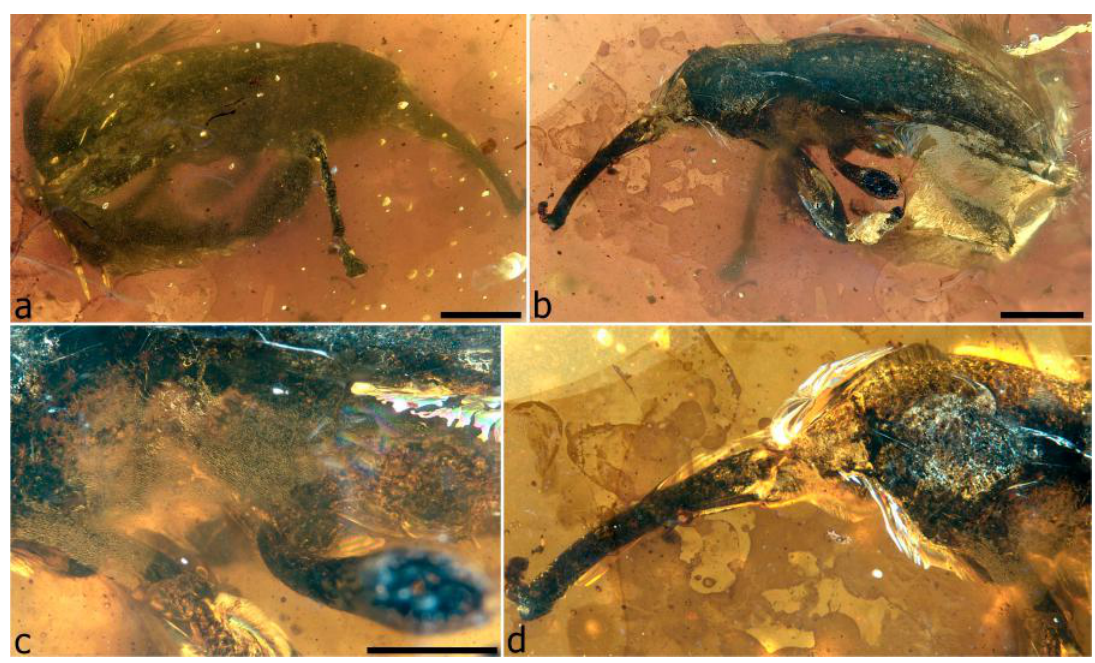
Figure 40. Petalotarsus cylindricus sp. n., holotype. Habitus, right lateral ( a ); left lateral ( b ); pro- and mesothorax, left lateral ( c ); head and prothorax, left lateral ( d ). Scale bars: 1.0 mm (a,b); 0.5 mm (c).